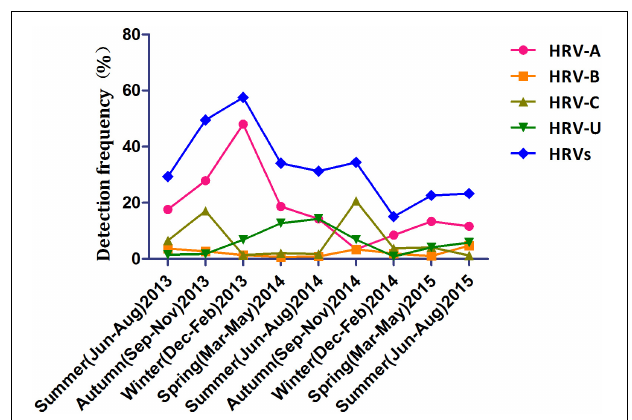
FIGURE 1 | Temporal distribution of the HRV species between June 2013 and August 2015 inclusive.